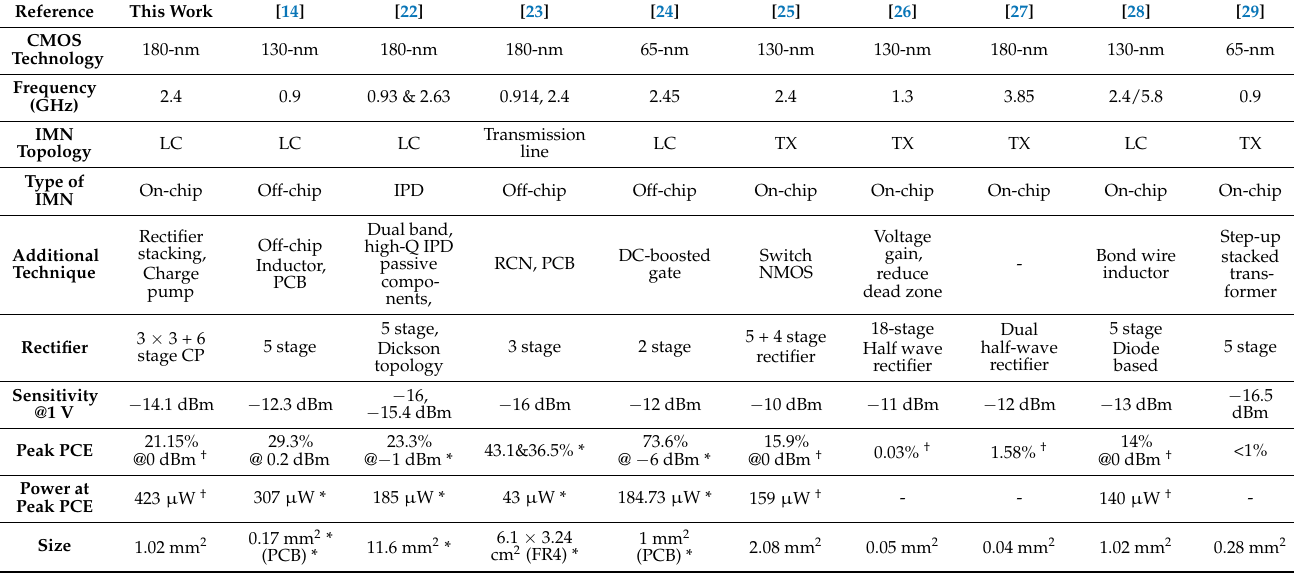
Table 3. Performance benchmark with related